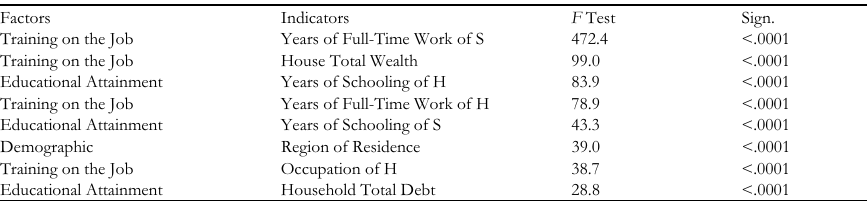
Formative Indicators (and statistical significance) of the HC estimation for Italian